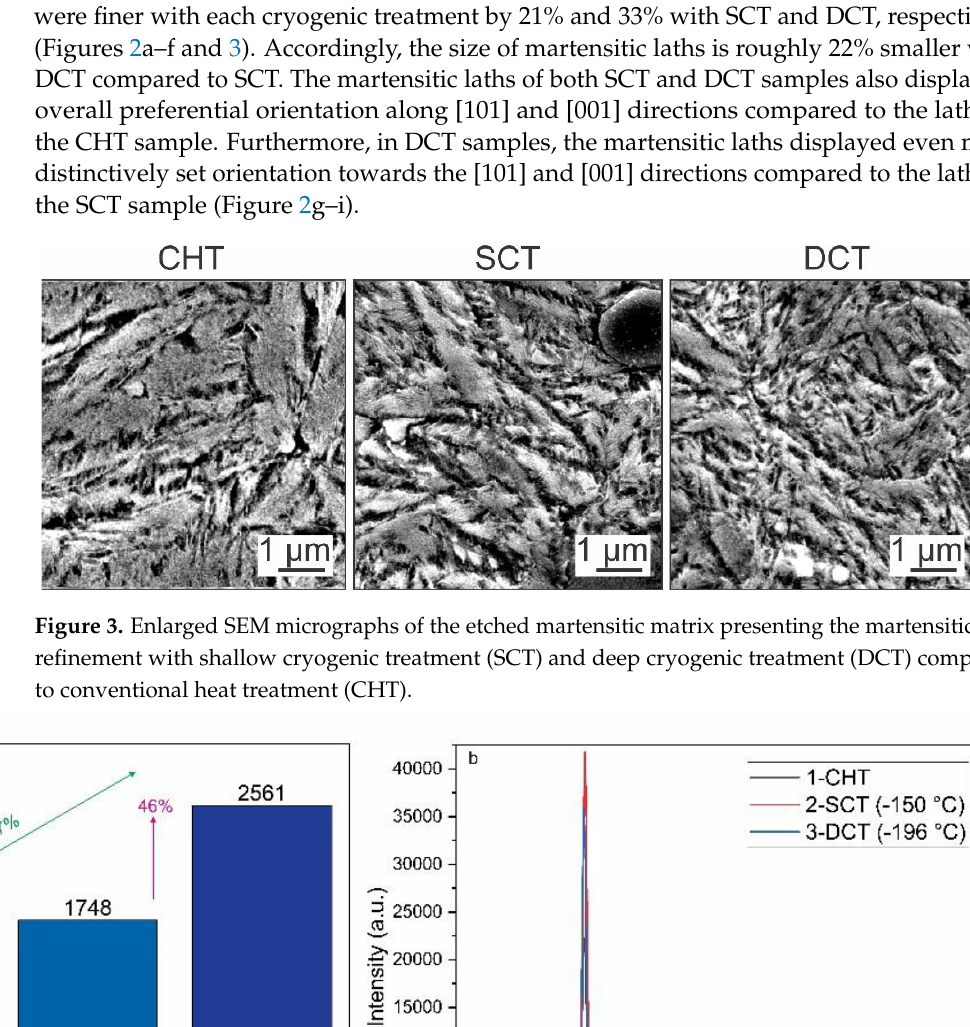
Table 1. Mean volumetric fractions of phases present in the samples; CHT — conventionally heat- treated; SCT — shallow cryogenically heat-treated; DCT — deep cryogenically heat-treated. Phase (vol.%)